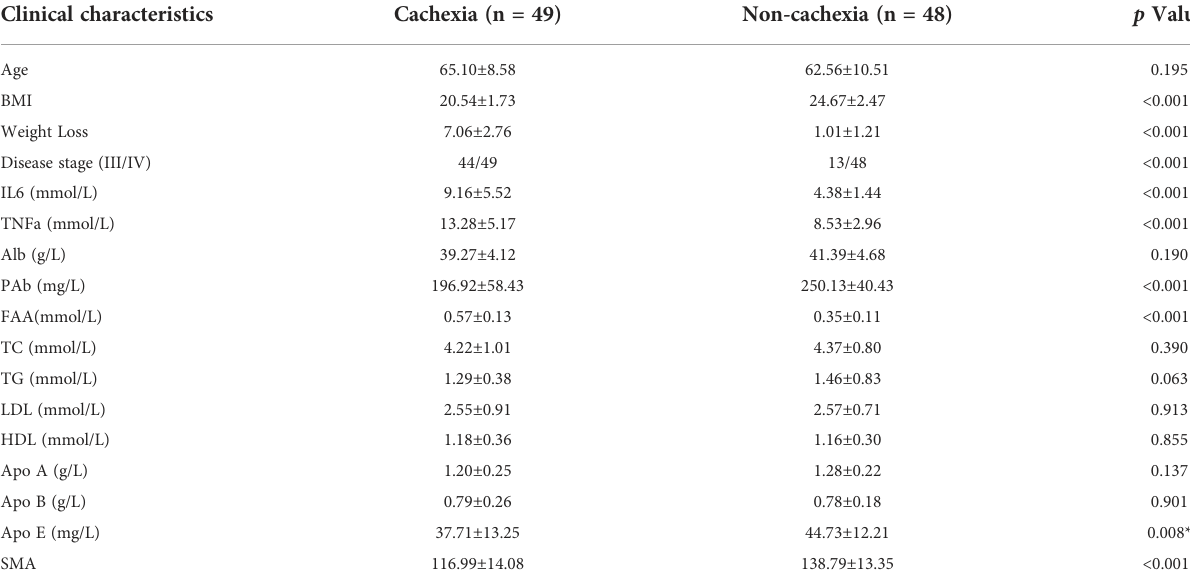
TABLE 2 Clinical characteristics of 97